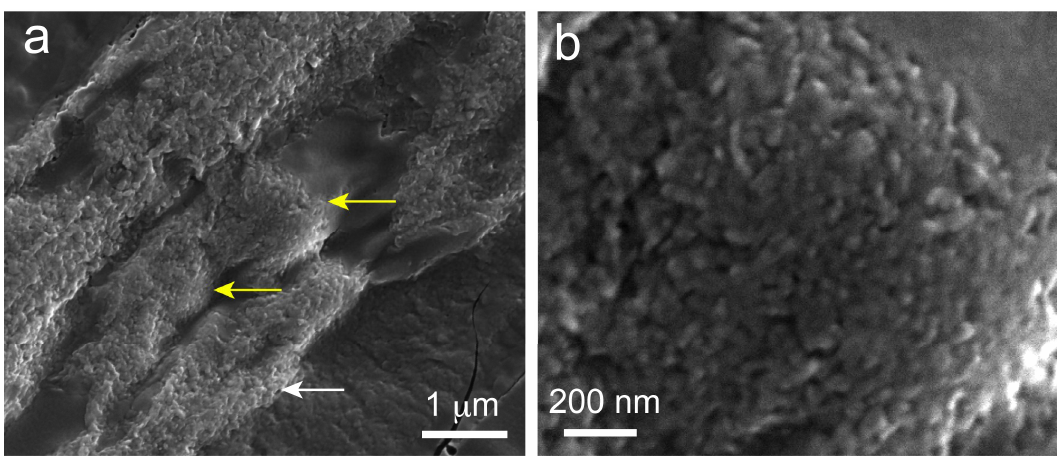
Figure 6. SEM images of a cross-sectional sample. ( a ) Low-magnification image showing irregularly shaped precipitates (white arrow) and ball-like ones (yellow arrows). ( b ) High-magnification images of ball-like precipitate showing nanoparticles sized approximately 50 nm.